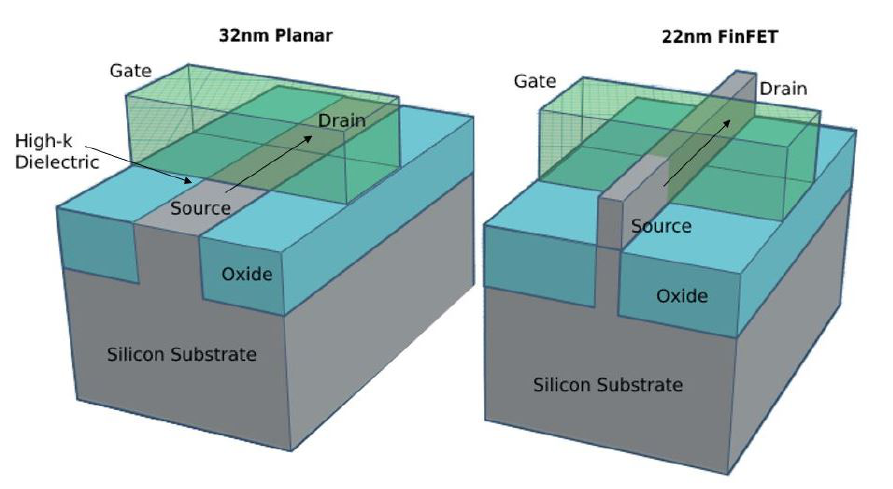
Figure 7. Planar CMOS Structure vs. Non Planar FinFET Structure.